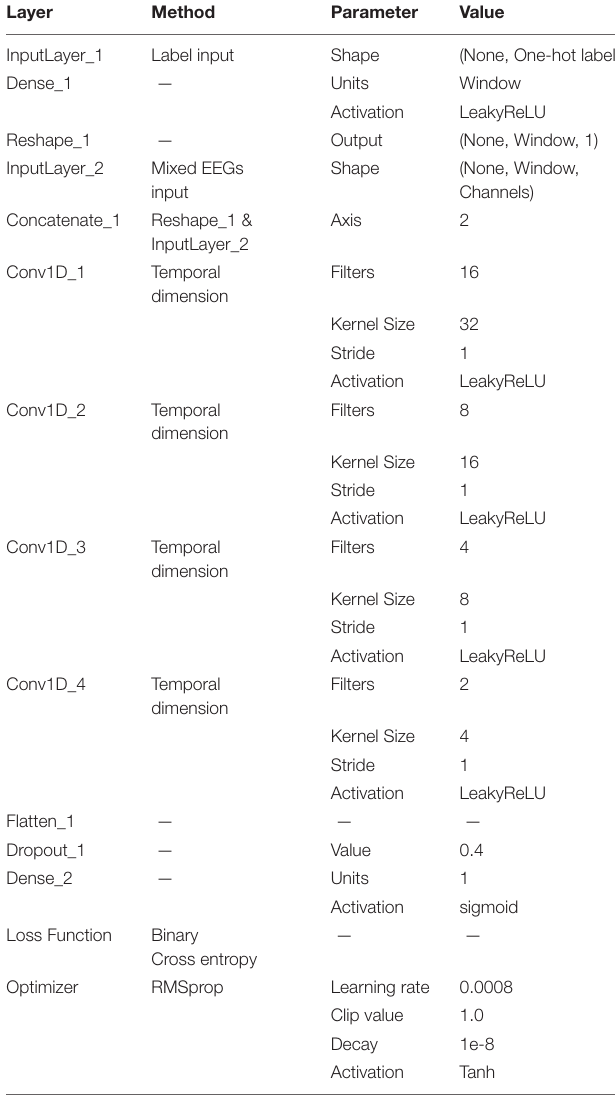
TABLE 2 | Summary of the discriminator.